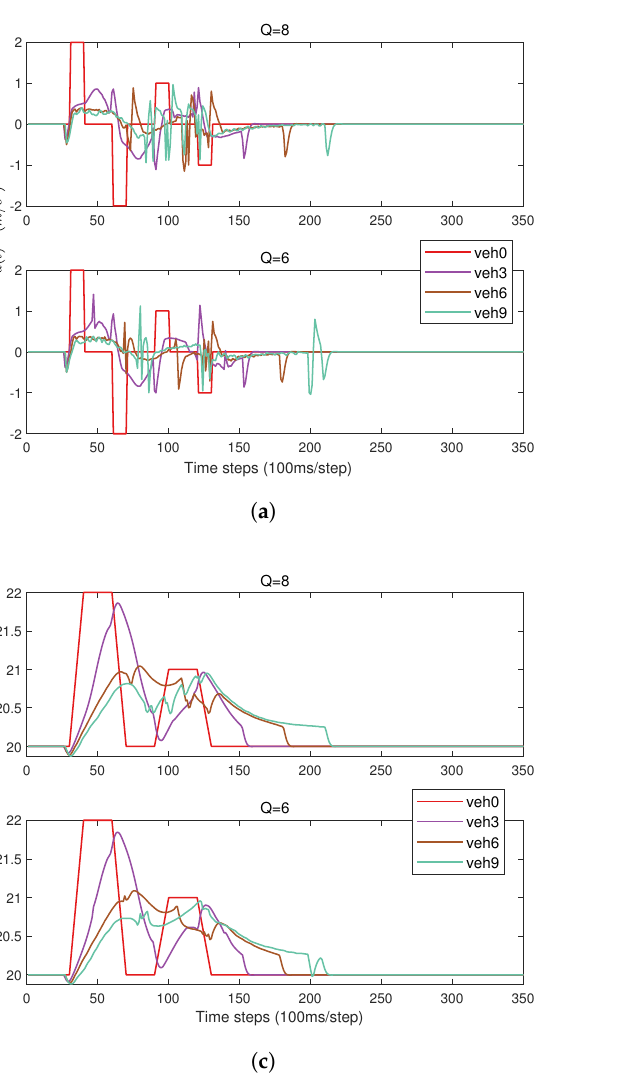
Figure 4. Vehicle acceleration, rate of vehicle acceleration change, velocity, and torque with different numbers Q of reusable uplink channels. ( a ) Acceleration; ( b ) Rate of acceleration change; ( c ) Velocity; ( d )